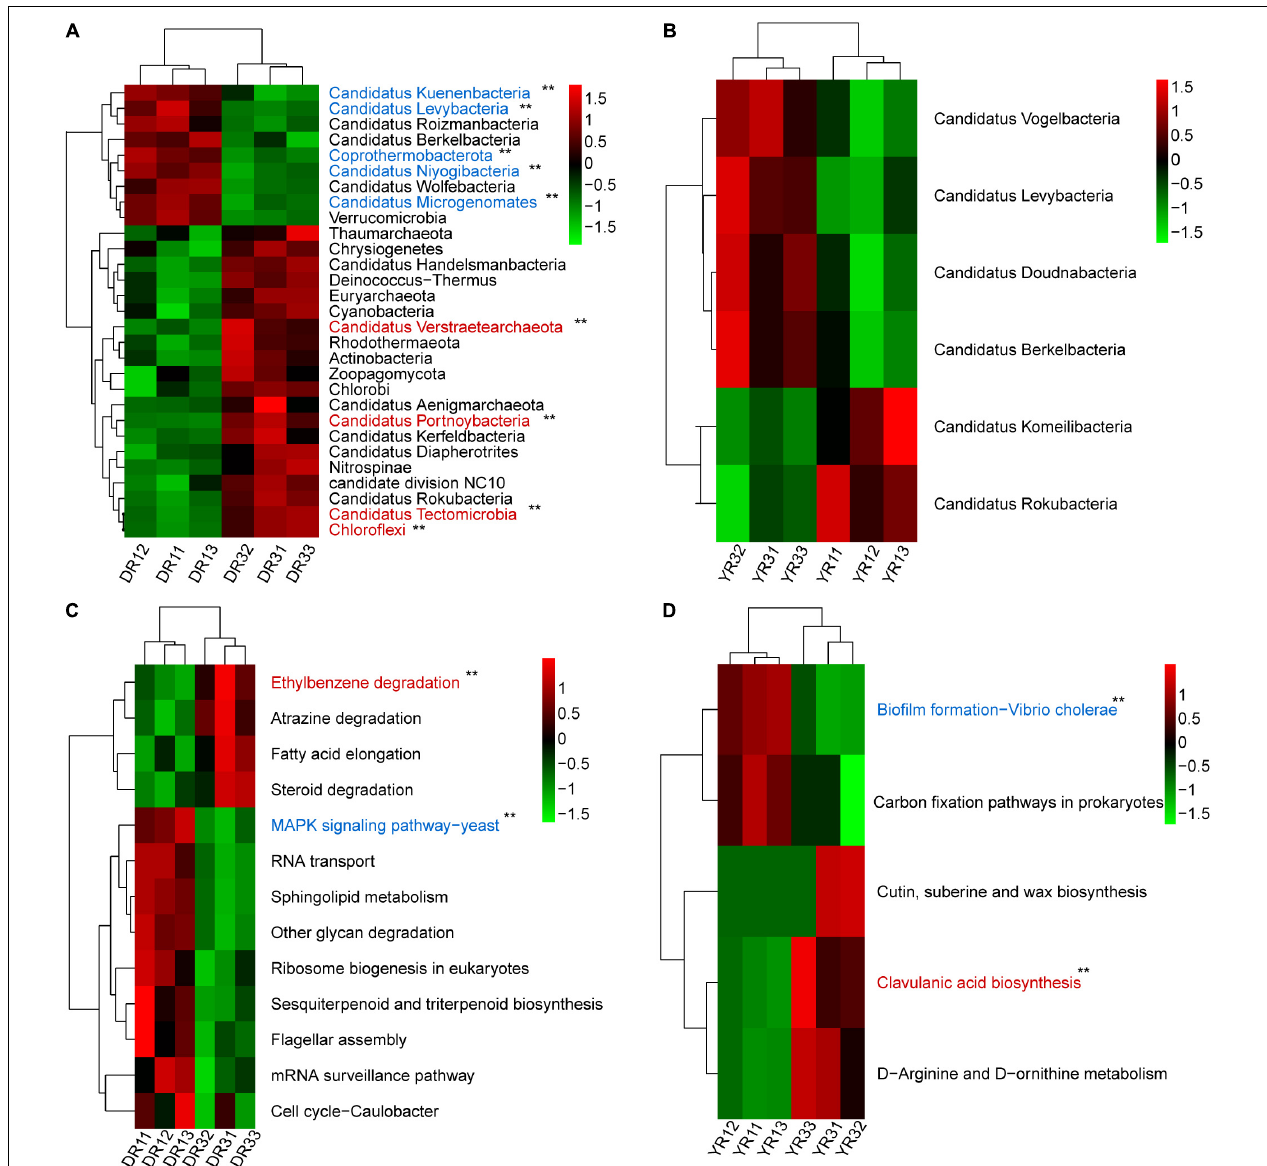
FIGURE 5 | The heatmap of difference analysis of microbial communities and KEGG pathways. (A,B) The heatmap of the relative abundance of microorganisms at the phylum level in Dali (A) and Yuxi (B) . (C,D) The heatmap of the relative abundance of KEGG pathways in Dali (C) and Yuxi (D) . Only the microorganisms and KEGG metabolic pathways are presented whose relative abundance showed a significant difference ( p < 0.05). The p -value of the microbiome and KEGG pathways marked with “**” was < 10 − 4 based on the significance analysis, with the blue one enriched in the non-diseased group and the red one enriched in the severely diseased group. DR1_ and DR3_ (_ = 1, 2, 3) represent the rhizosphere soil in non- and severely diseased groups from Dali, respectively. YR1_ and YR3_ represent the corresponding samples from Yuxi.